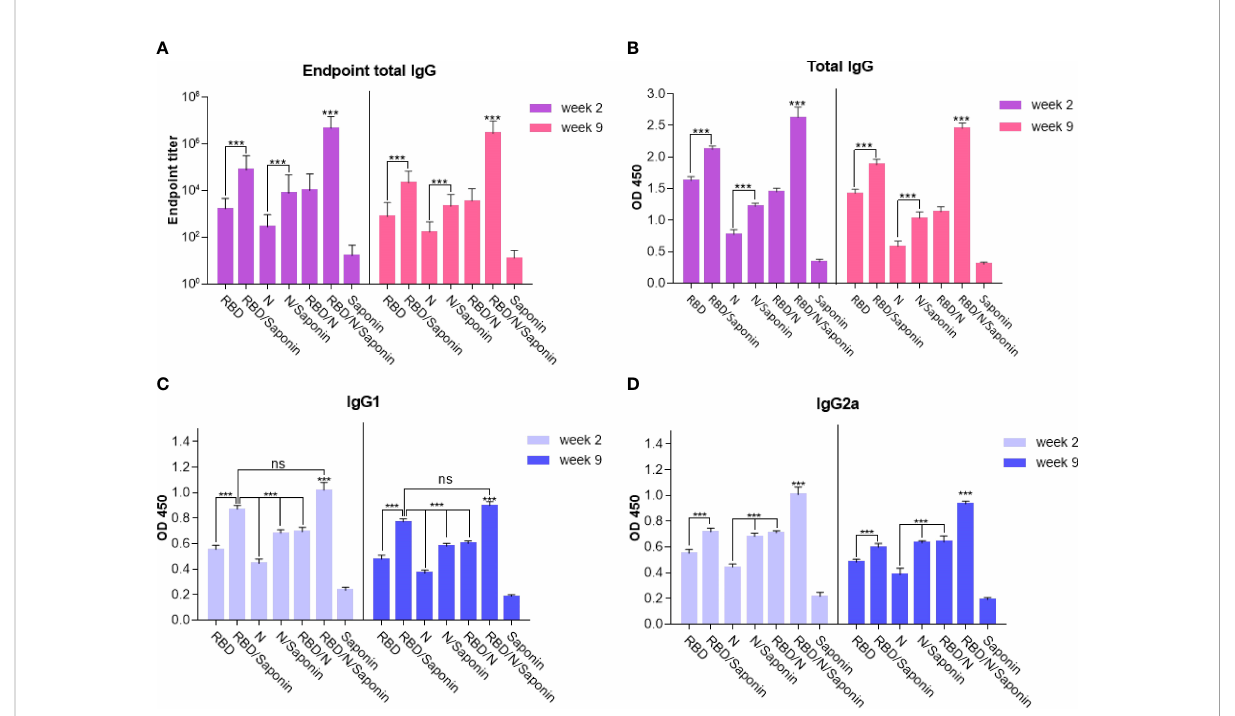
group and difference among individual groups is determined by One way ANOVA and shown as *** for P< 0.001, and ns for a nonstatistical difference. Compared to different formulations or control groups, saponin-adjuvanted RBD/N vaccine signi fi cantly induced the highest level of endpoint total IgG and IgG2a